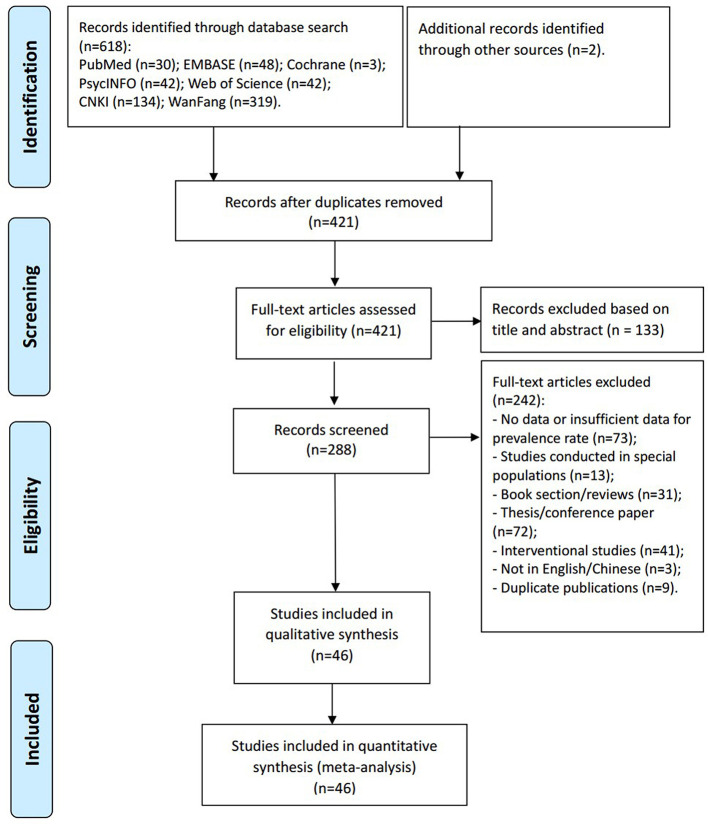
PRISMA flow chart.